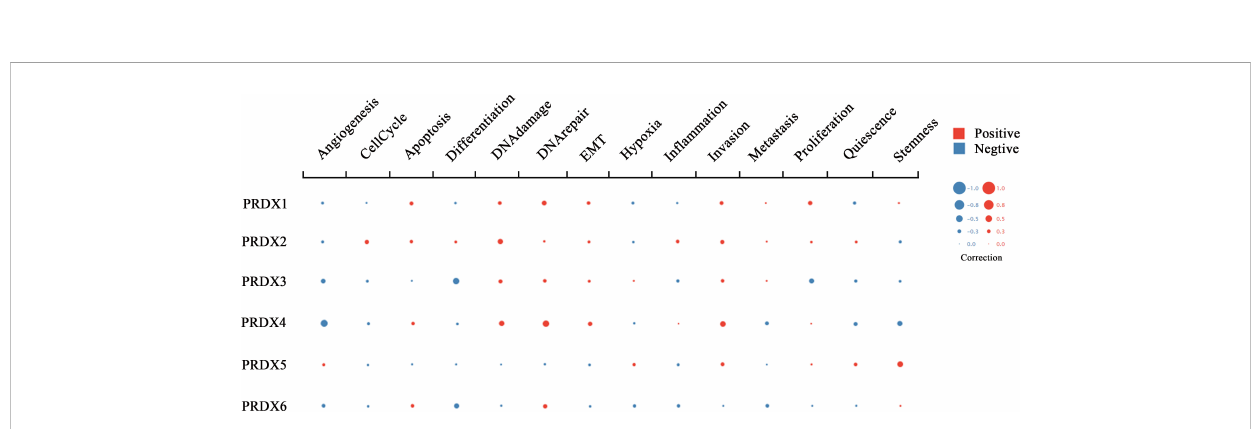
FIGURE 9 Functional state analysis of PRDX family members in CRC (cancerSEA). Functional relevance of each PRDX member in CRC cells. The size of the bubble indicates the strength of the correlation; red represents a positive correlation and blue represents a negative correlation. CRC, colorectal